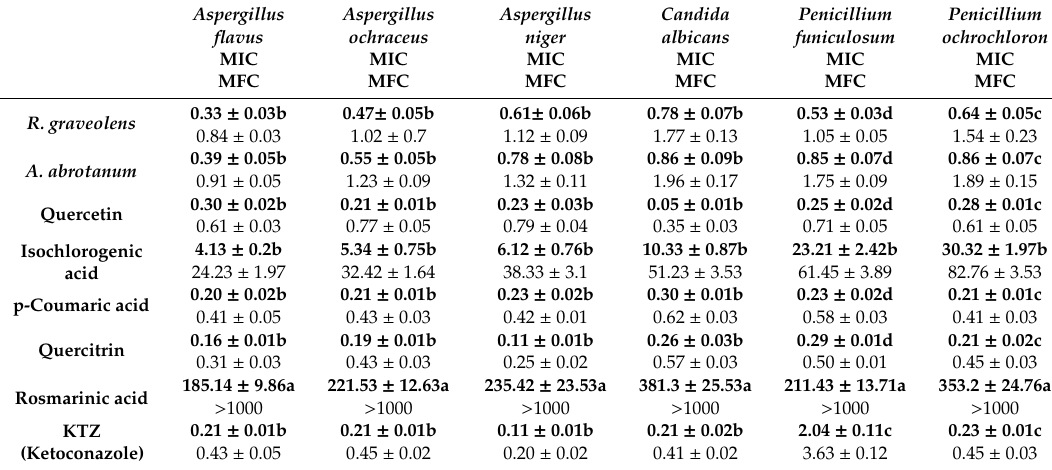
Table 5. Minimum inhibitory concentration (MIC) and minimum fungicidal concentration (MFC) of the methanolic leaf extracts of Ruta graveolens and Artemisia abrotanum (and the identified polyphenols pure standards) against a range of fungal species (mg / mL). Values are means of three replicates in (mg /